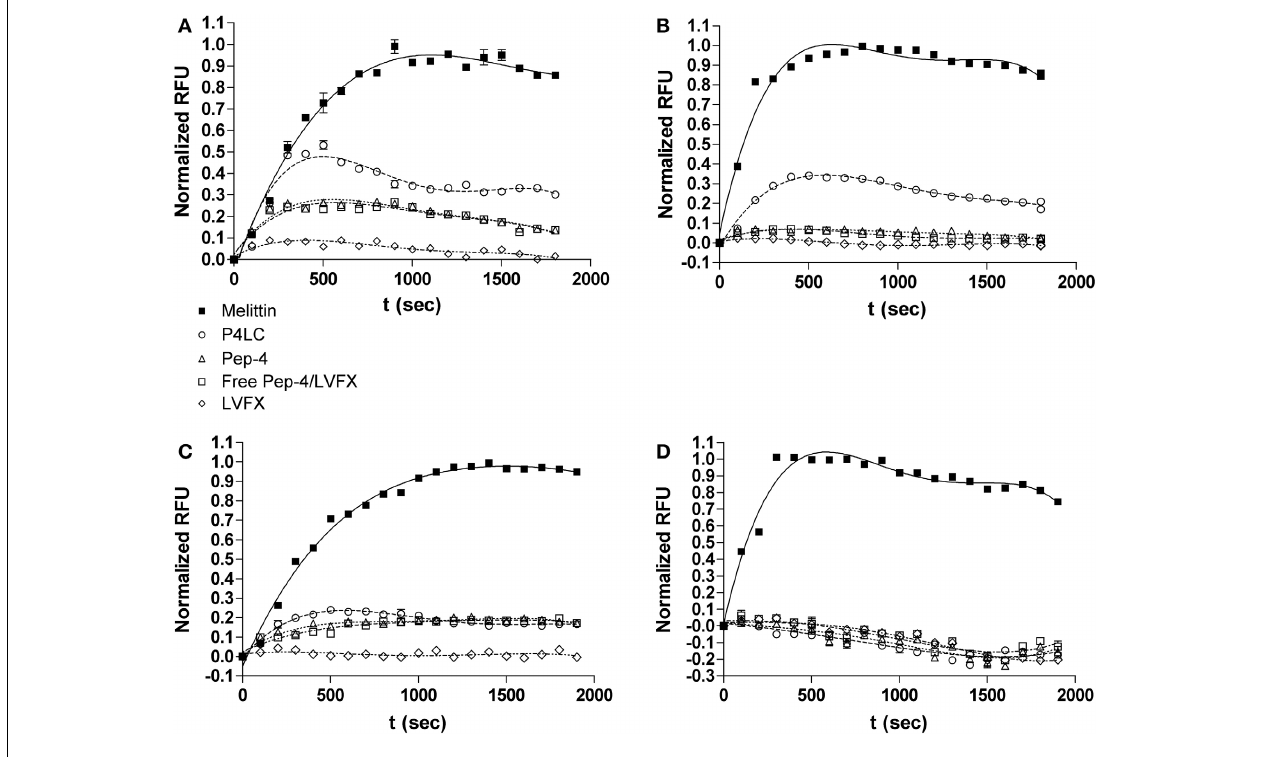
FIGURE 5 | Depolarization (top row) and perturbation (bottom row) of E. coli membranes (A,C) and B. cereus membranes (B,D) induced by P4LC, Pep-4, Pep-4/LVFX, LVFX and melittin.